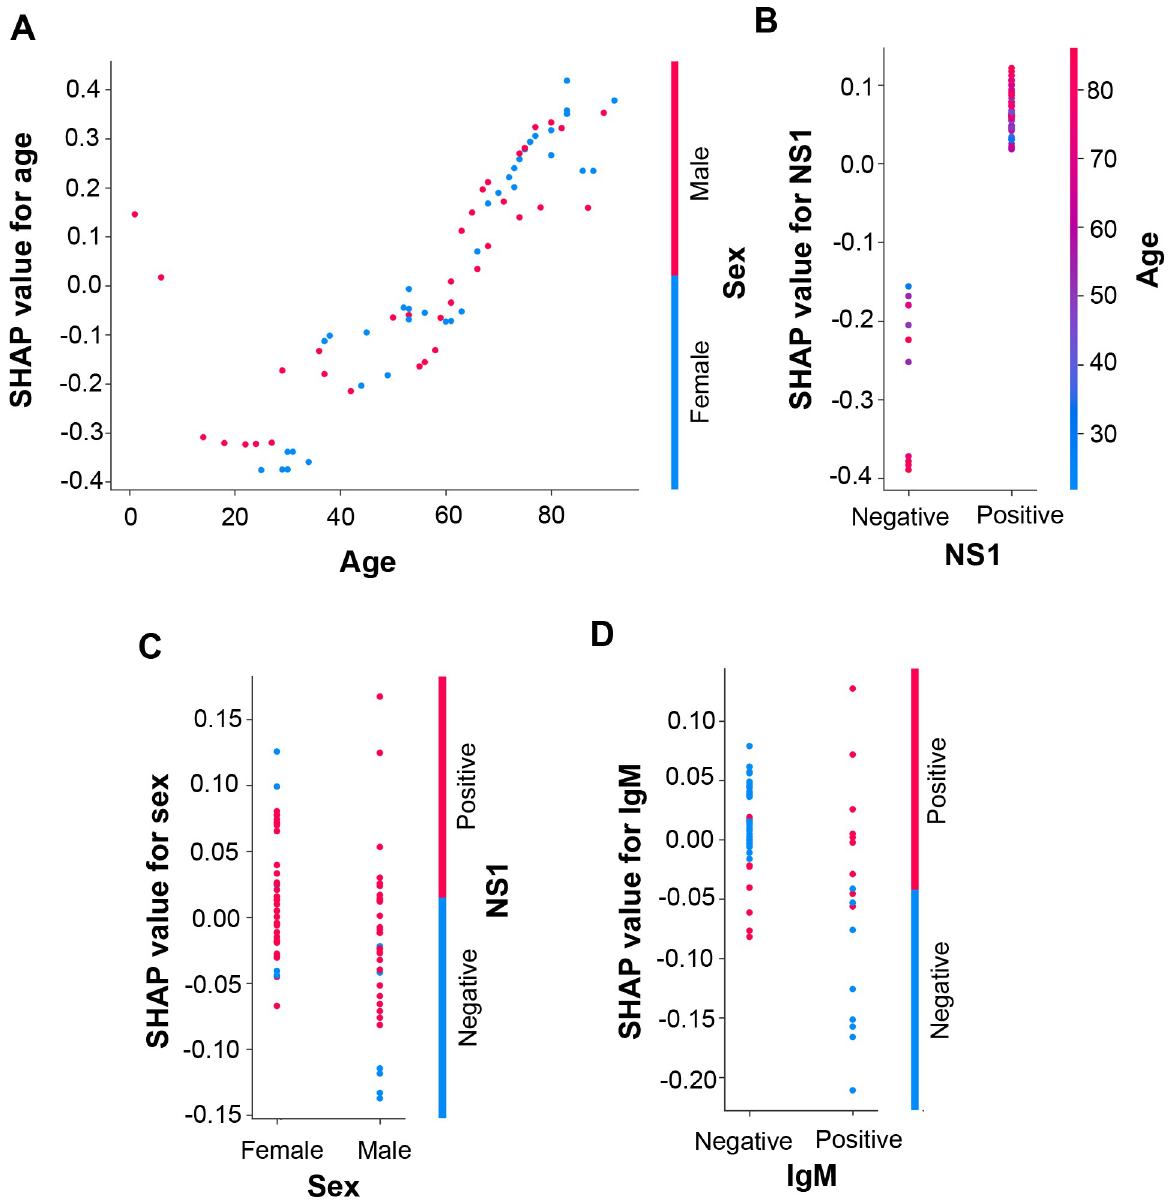
Fig 3. Dependence plots of the ANN model using SHAP explainer. Dependence plots of the ANN model showed the potential cooperative effects of feature pairs on prediction outcomes. For each feature, its most associated feature was chosen to be analyzed using dependence plots. The feature pairs included (A) age and sex, (B) NS1 and age, (C) sex and IgM, and (D) IgM and